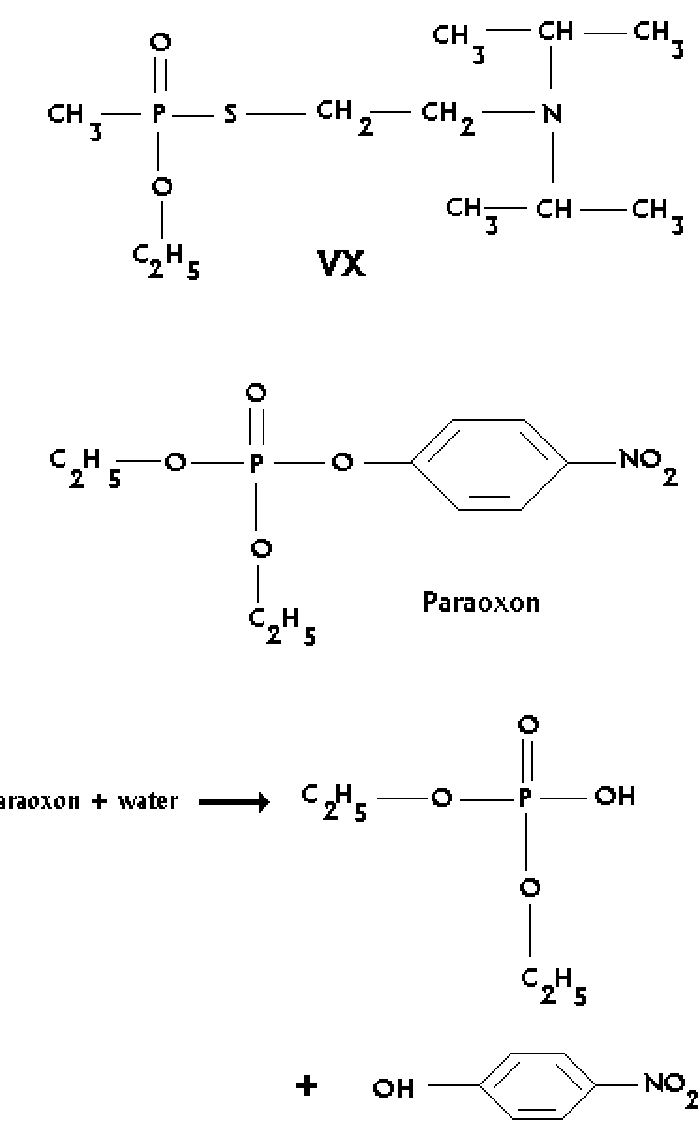
FIGURE 2 . Structures of VX and paraoxon, and products of paraoxon hydrolysis.